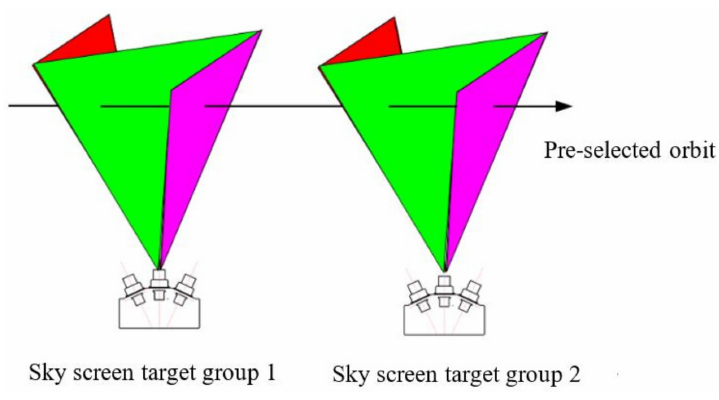
Figure 1. Screen side view of double-N six-light